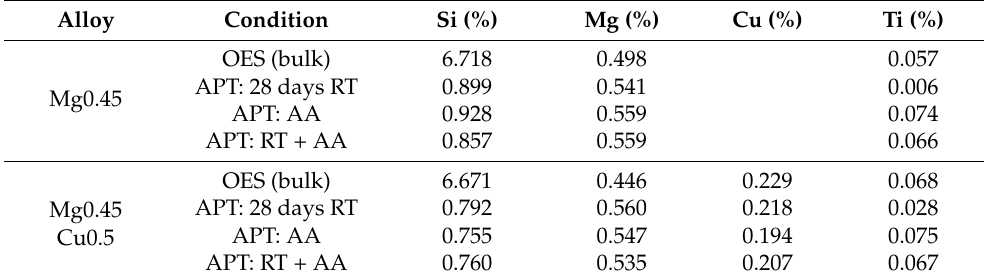
Table 2. Measured bulk composition and composition of Al grains by APT and other techniques (at.%). A discussion of error sources in APT is available in the Supplementary Material [43]. Alloy Condition